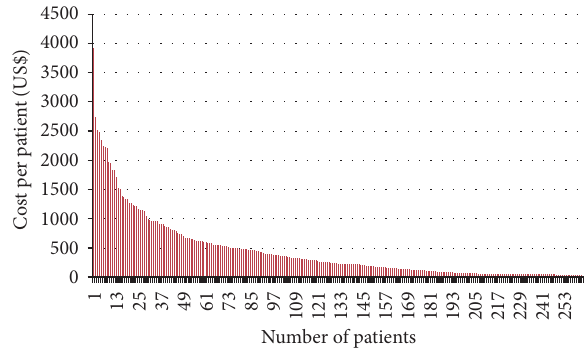
Table 3: Descriptive statistics of respondents: CHAP cohort.